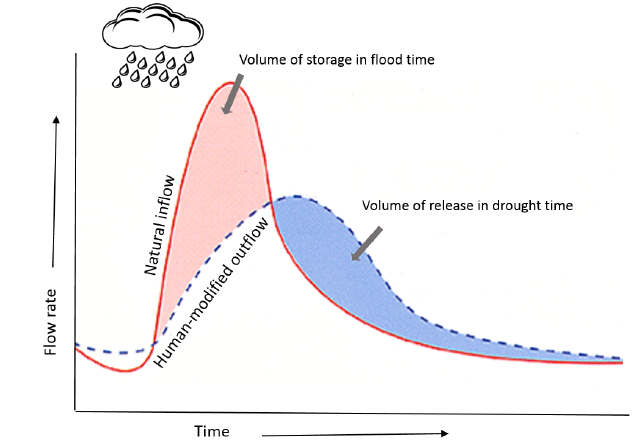
Figure 1. Human impact on hydrological extremes. Schematic ex- ample of the impact of dams and reservoirs, which tend to mitigate both hydrological extremes, i.e. lower outflow (blue dashed line) during high-inflow (red line) conditions and higher outflow during low-inflow